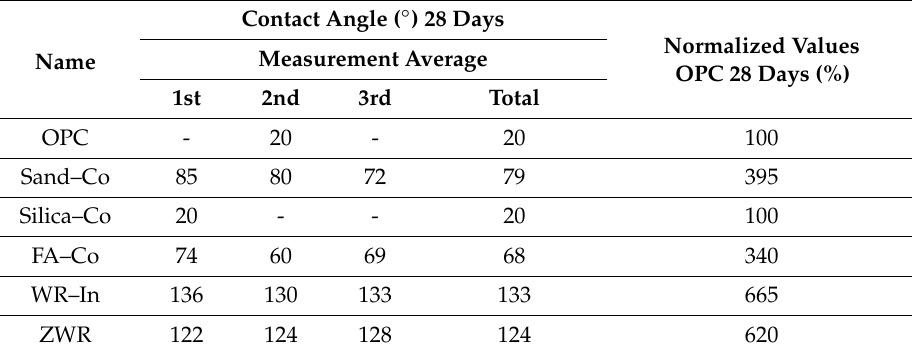
Table 11. Result of contact angle (sessile drop method).